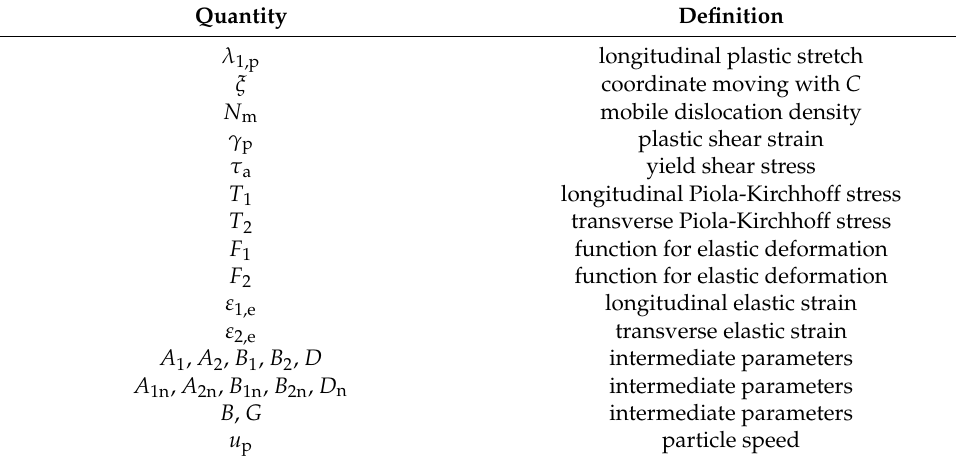
Table 1. Definitions of relevant quantities in Equations (21)–(46)